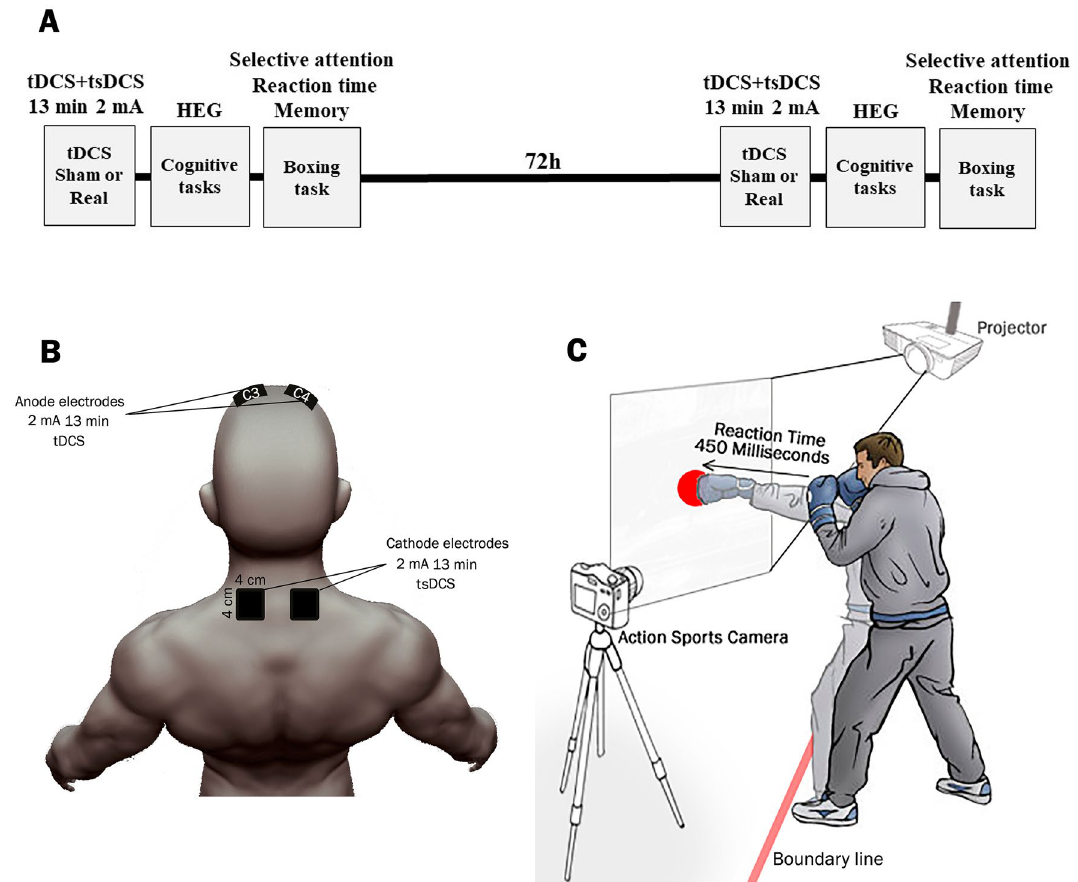
Figure 1. Study protocol, the tDCS + tsDCS montages used for brain stimulation and boxing task. ( A ) Participants were randomly assigned to either sham or real tDCS + tsDCS at 2 mA for 13 min over the first session. Then, they performed 2 tasks including spatial span (short-term memory) and double trouble (response inhibition) from CBS-cognitive platform (see “Materials and methods” section) with the intervals of 2 min’ rest. CBS-CP and the HEG data were concurrently recorded while subjects carried out the tasks. Later, they performed the boxing task and their selective attention, reaction time and Short-term memory were recorded. After 72 h, the real group received sham tDCS + tsDCS whereas sham group received real tDCS for 13 min and they performed the rest of the tasks similar to the first session. ( B ) 2 mA anodal tDCS pad electrodes were placed over the C3 and C4 (M1 hand area) for a course of 13 min. Both cathodal electrodes were placed bilaterally adjacent to spinous processes of C5-T1 and were not overlapping. The size of the electrodes is depicted in the Figure. ( C ) The participants stood at the same distance from the wall every 2 days. Ten circles appeared on the wall with random intervals. The period between the appearance of the circles on the wall and the impact of the boxers’ punch on them was considered as reaction real tDCS in the second session, and vice versa. Following the brain stimulation, boxers were asked to per- form 2 tasks from the Cambridge Brain Sciences Cognitive Platform (CBS-CP). Simultaneously, hemodynamic response of left frontopolar region (FP1) was evaluated using the hemoencephalography (HEG). Afterward, the boxer warmed up and performed three maximal contractions in each hand using the handgrip strength evalua- tion. Boxers were then required to perform three boxing tasks (selective attention, reaction time and visuospatial working memory) (Fig. 1A). Transcranial direct current stimulation (tDCS). Real or sham tDCS was delivered by electric stimula- tor (Neurostim-2, Medina Teb, Tehran). In each experimental session, saline-soaked sponge coated electrodes (4 * 4 cm 2 ) were placed on the regions of interest as described below. Skin sites under electrodes were cleaned up with alcohol. Two anodal electrodes were positioned bilaterally over C3 and C4 area (M1 hand area) based on the international 10–20 EEG electrode placement system, while the two cathodal electrodes were placed bilater- ally adjacent to spinous processes of C5-T1 and were not overlapping. In the real session, the current ramped up from 0 to 2 mA in 30 s and maintained constant for 13 min. In the sham session, the sham stimulation followed the same montage of real stimulation while after 30 s, despite ongoing count down and light indicators, the elec- trical current was turned off automatically (Fig. 1B).